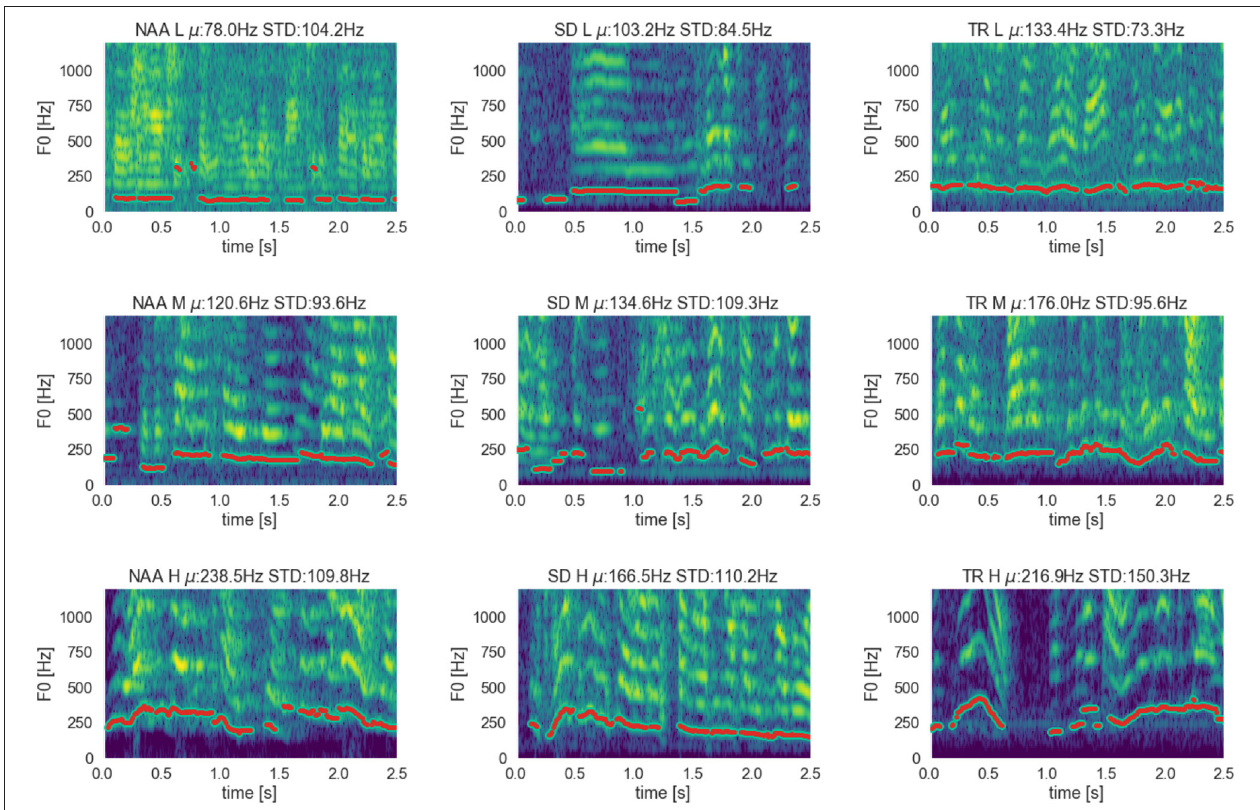
FIGURE 4 | Spectrogram representation of three males samples (one for each escalation class) for the three corpora being analyzed in this study. Showing for each escalation class (L)ow, (M)edium, and (H)igh, and reporting mean ( µ ), and standard deviation (STD) for Pitch (F0).